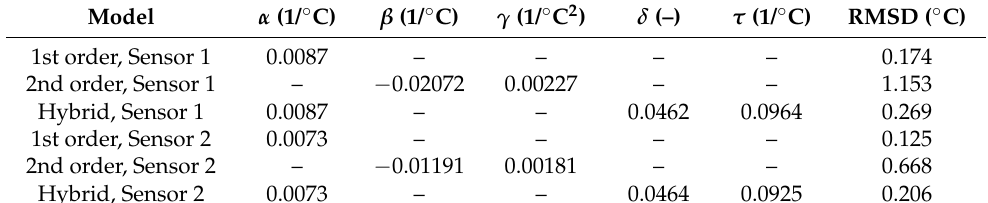
Table 2. Optimal values of approximation coefficients and corresponding RMSD of three models.